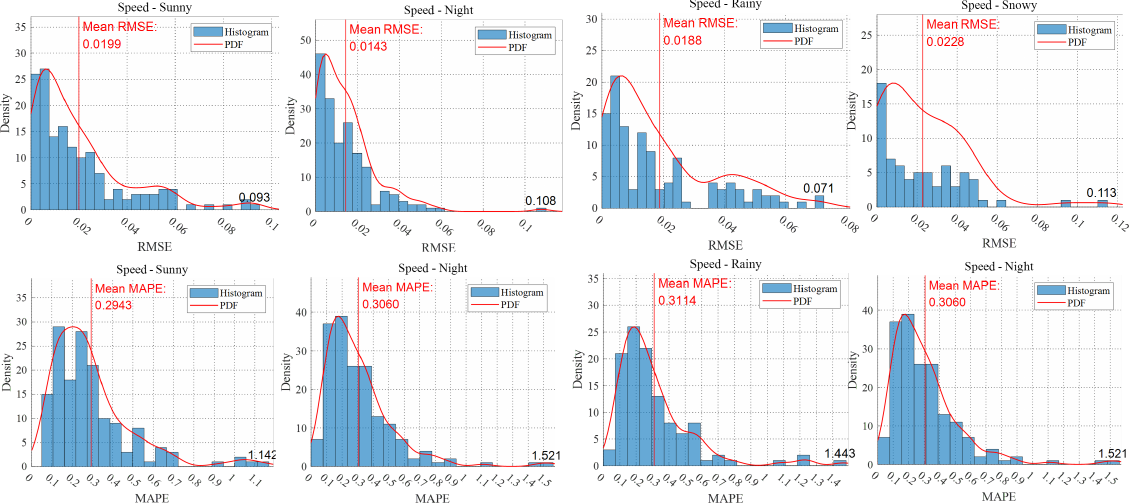
Figure 13. RMSE (first row) and MAPE (second row) histograms of extracted vehicle speed under different weather conditions in the labeled MWUAV dataset.